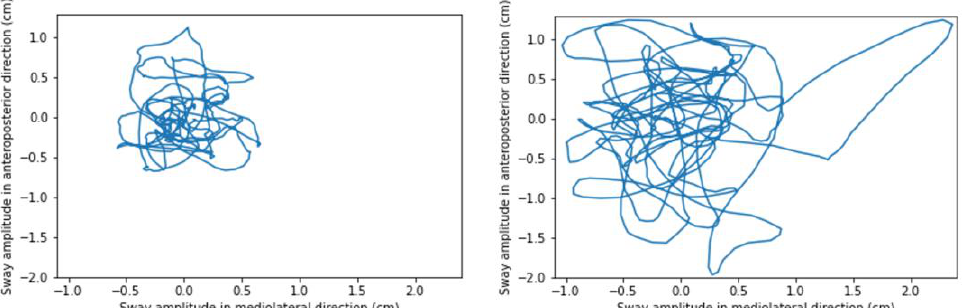
Figure 1. Example of a statokinesigram, representing the CoP trajectory of a subject with proprioceptive deficit, that we recorded standing with eyes open (on the left ) and eyes closed (on the right ) on a force platform.